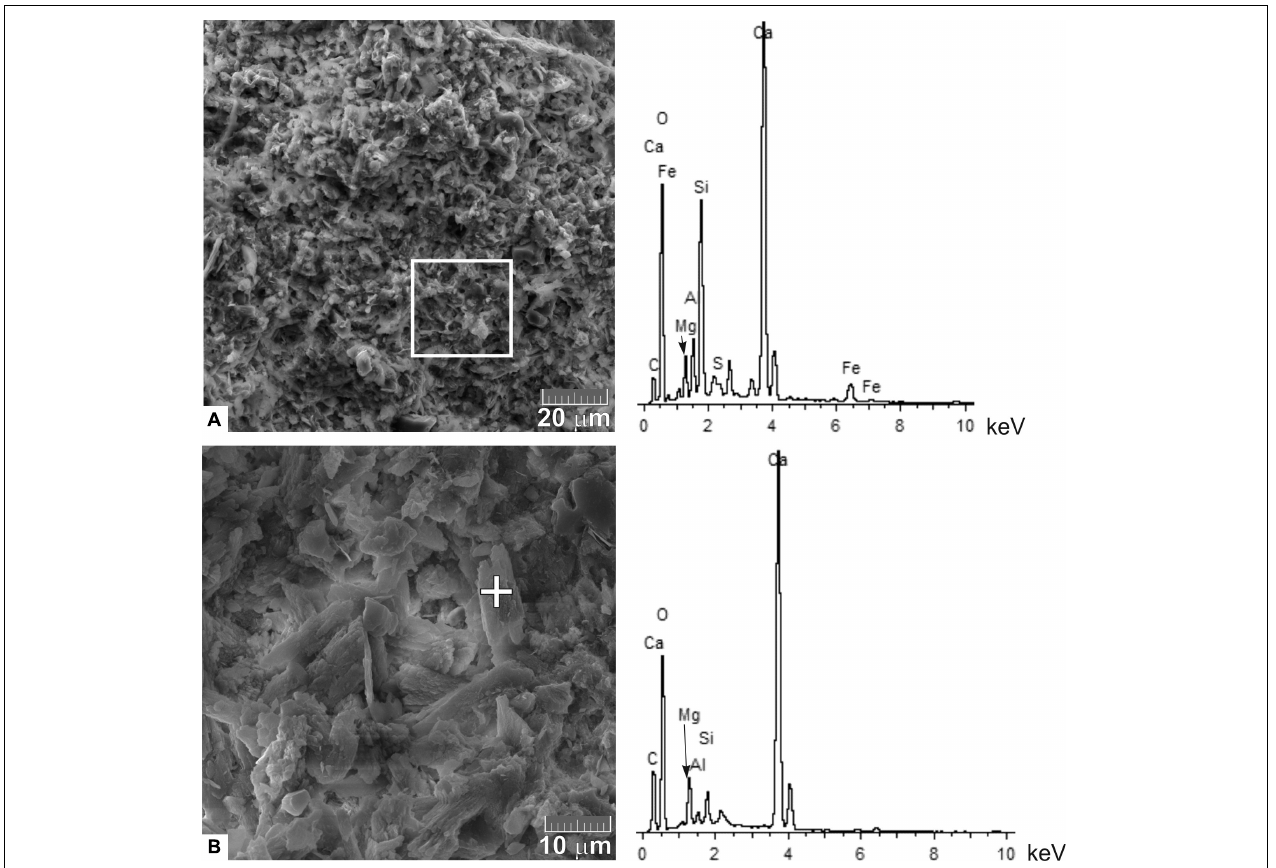
FIGURE 5 | Scanning electron micrographs of the fine-grained type of high-Mg calcite crystals in the micrite cement of the OD-I-1 carbonate crust: (A) the dark part (left) of the crust and the EDS data (right) for the area highlighted with a white square box; (B) the light part (left) of the crust and EDS data (right) of the mineral grain highlighted with a white